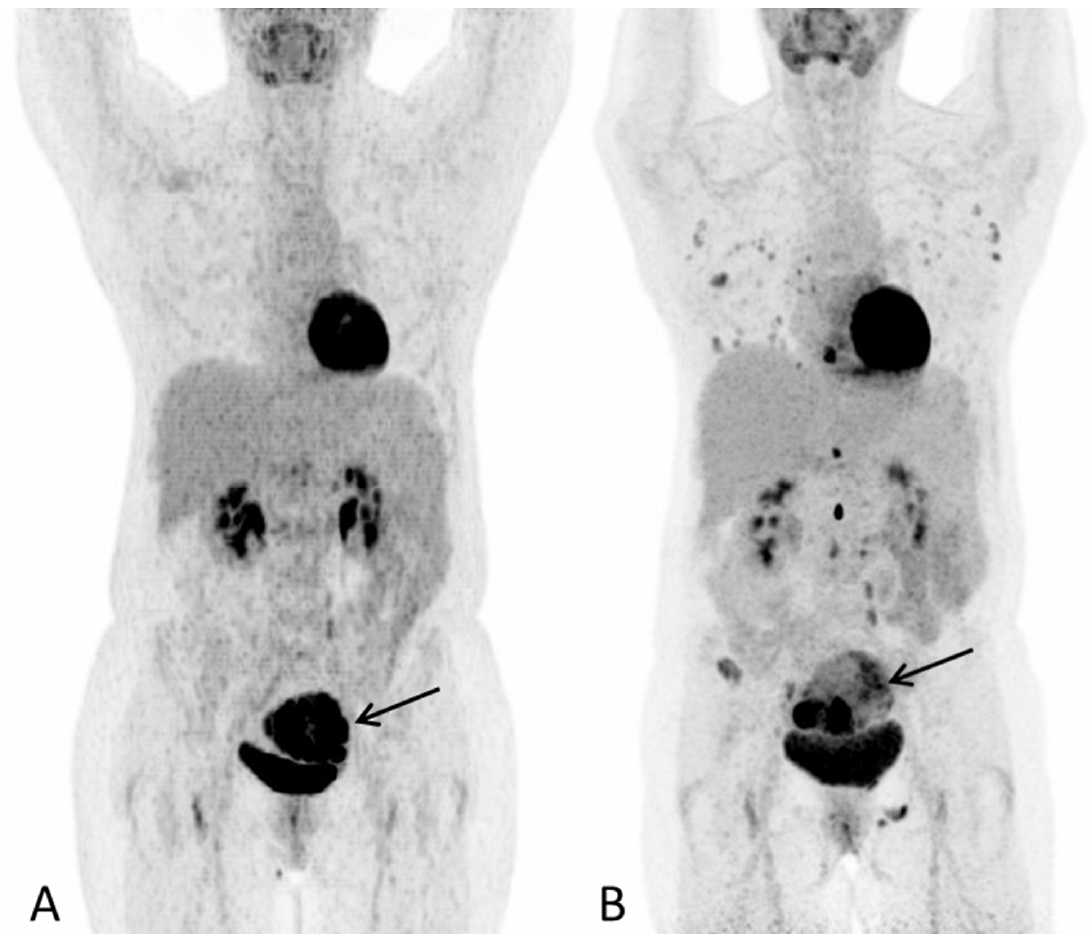
Figure 1. A 57-year-old post-menopausal woman underwent gynecological examination due to in-